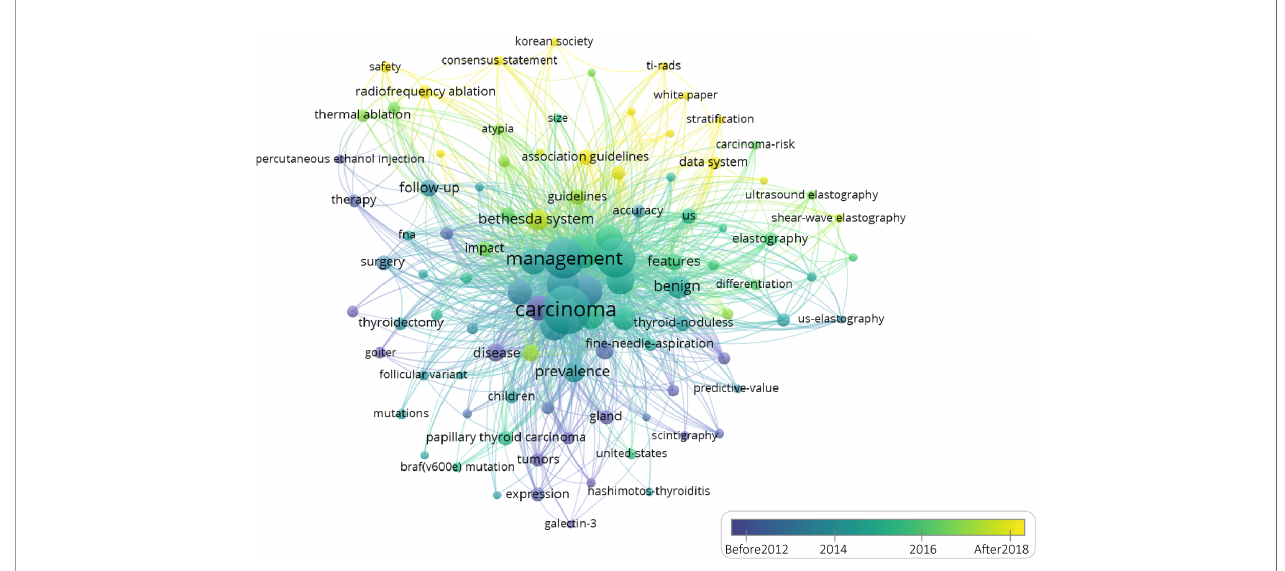
FIGURE 5 | The overlay visualization by publication time of the frontier topics in the top 100 most-cited TN articles from 2000 to